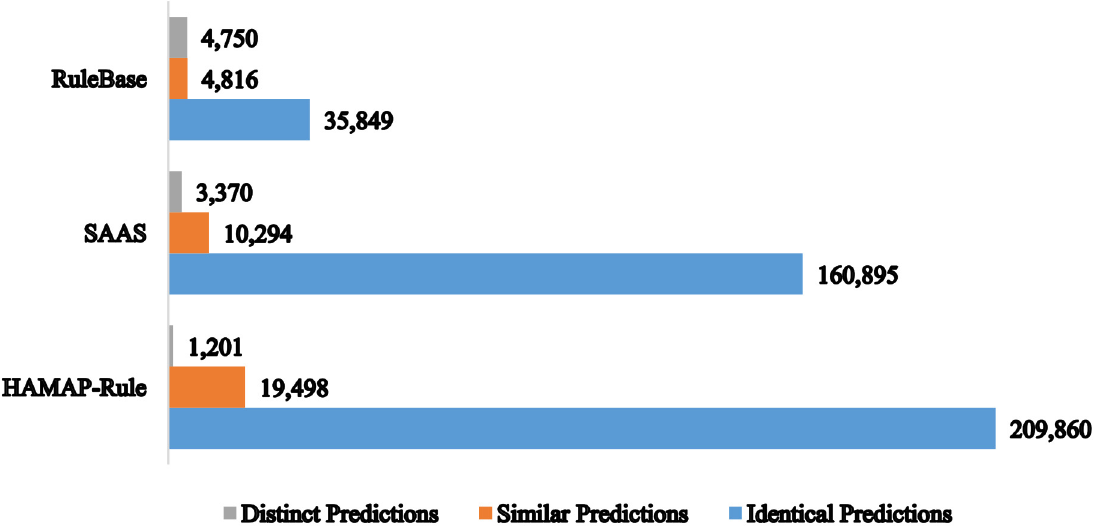
Fig 4. Comparison of predictions corresponding to UniProtKB/TrEMBL reference proteome prokaryotic entries touched by our system, Hamap-Rule, SAAS, and